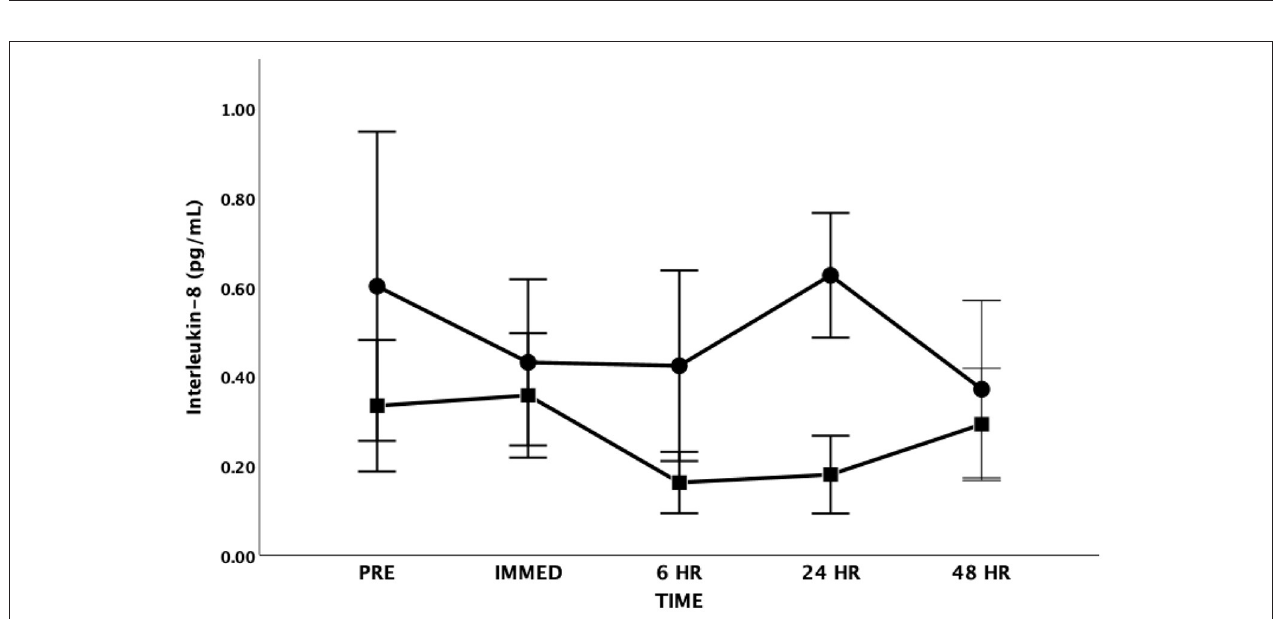
FIGURE 3 | Interleukin-8 (IL-8) as a function of time. Means ± SD. Circle = Steady State; Square = Interval. Error Bars = ± SEM.